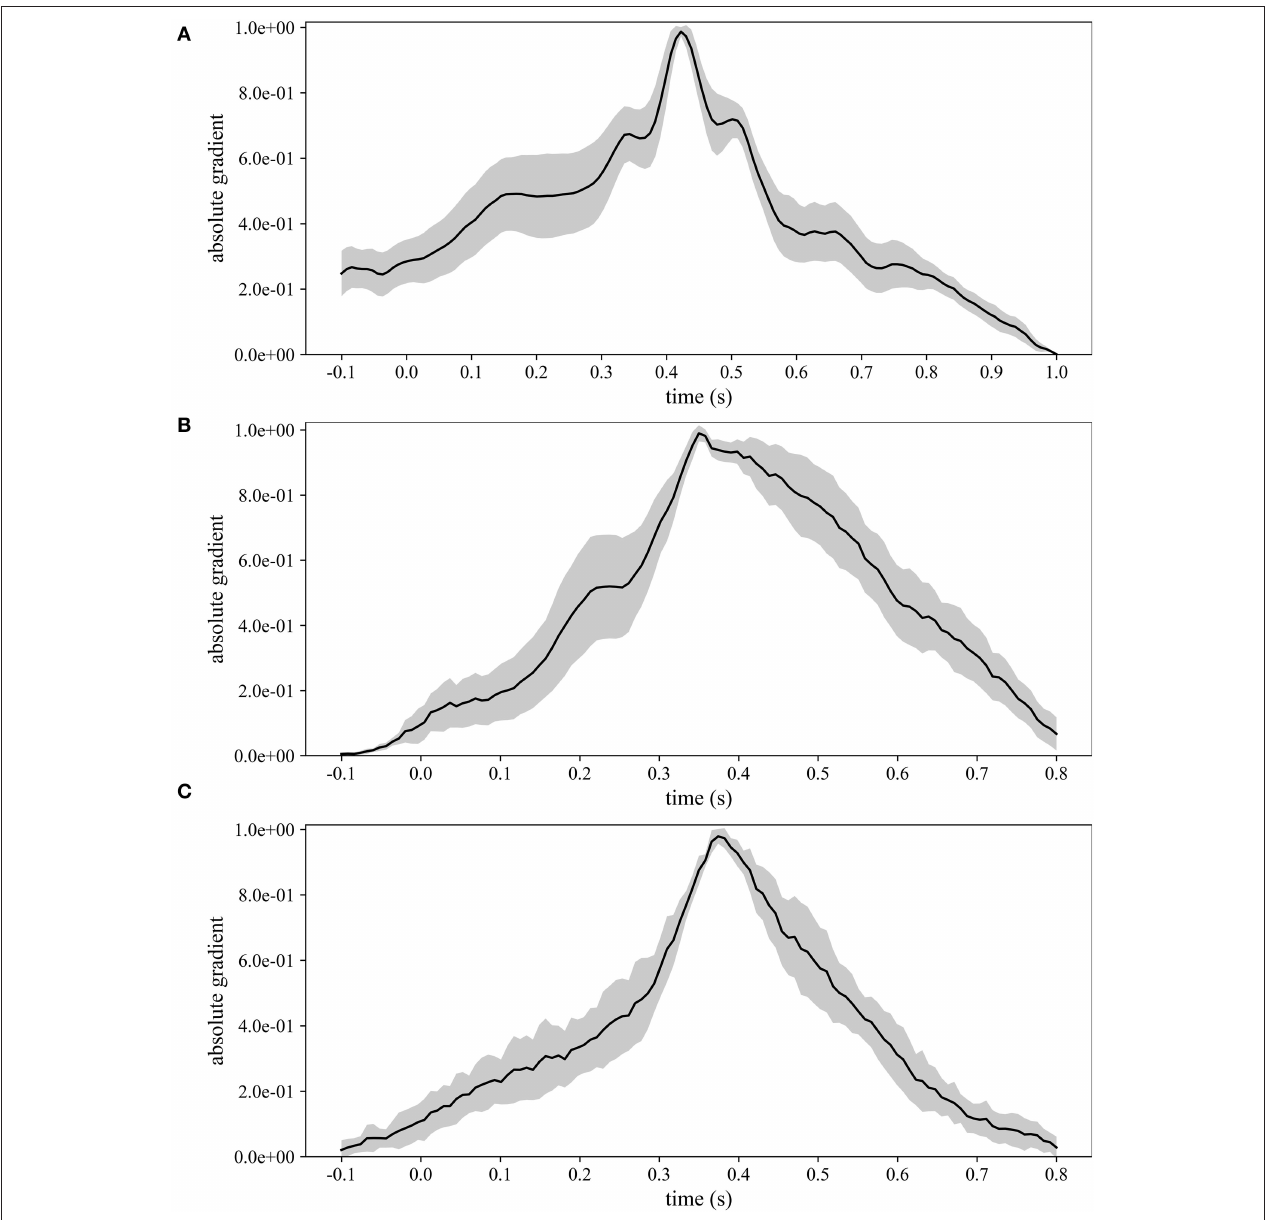
FIGURE 5 | Grand average absolute temporal representations of MS-EEGNet trained with the LOSO strategy using signals from datasets 1–3 (A–C) ; the mean value (black line) ± standard deviation (gray shaded areas) across participants are